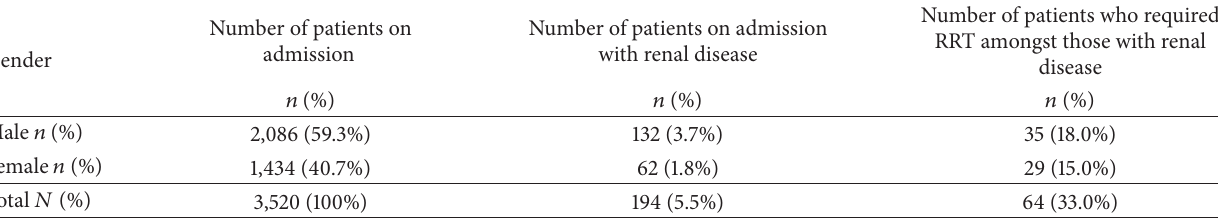
Table 1: The RRT required rate amongst the patients on admission.